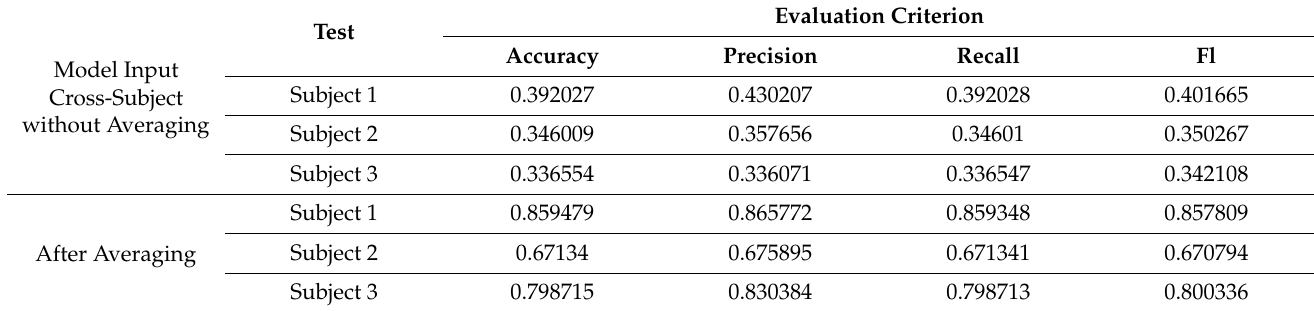
Table 3. Input criteria study for proposed DNN-based